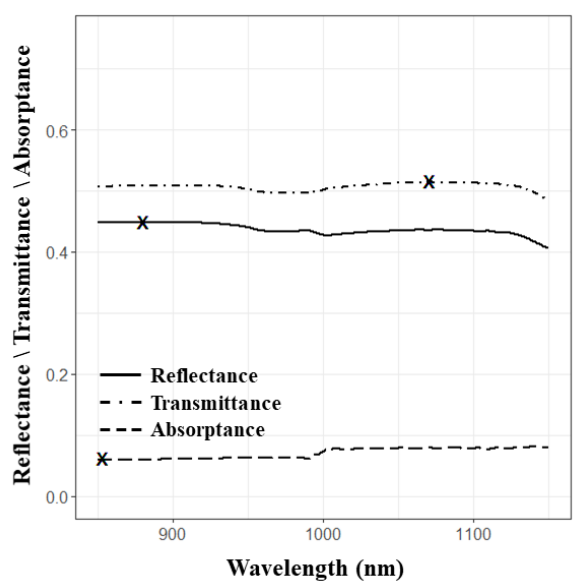
Figure 3. Comparison between measured reflectance and transmittance, and estimated absorptance (absolute difference between reflectance and transmittance) in the NIR region (850–1150 nm) of the wheat leaf from Figure 1. The black ‘X’s mark the approximate locations of maximum reflectance ( λ 1 = 880 nm) and transmittance ( λ 2 = 1071 nm), and minimum absorptance ( λ 3 = 853 nm) in the NIR region .